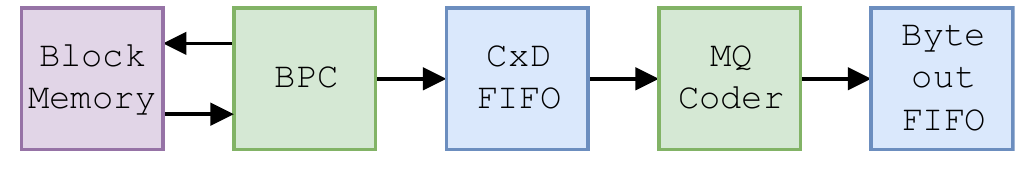
Figure 5. Tier 1 coder